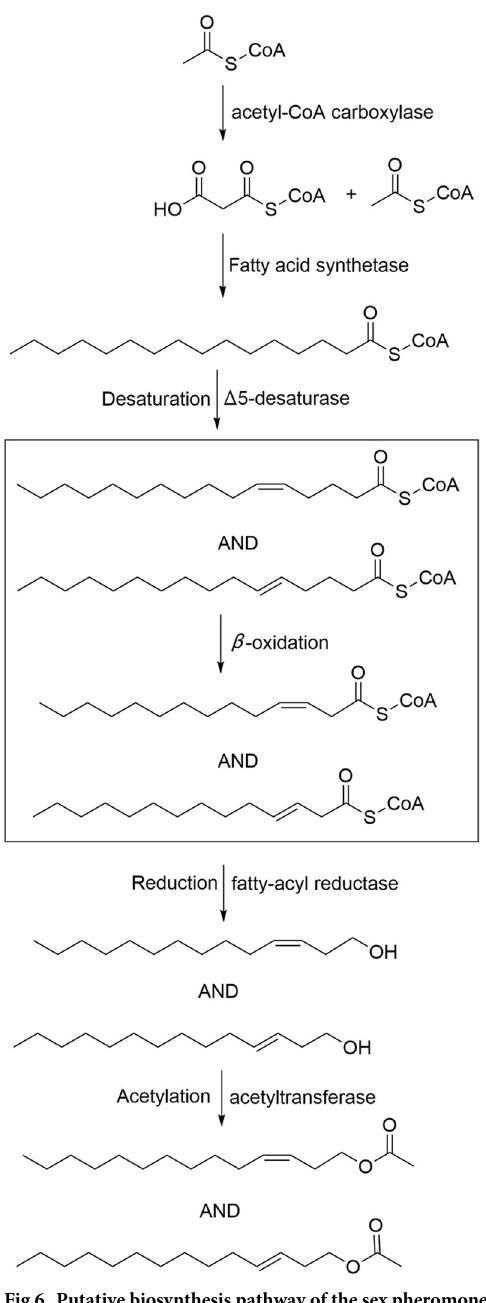
Fig 6. Putative biosynthesis pathway of the sex pheromone components Z3-14:OAc and E3-14:OAc in S . insularis . The saturated fatty acid precursor palmitic acid (16:0) is desaturated by Δ 5-desaturase to form the precursor Z/E5-16: acyl-CoA in the production of two major pheromone components (Z3-14:OAc and E3-14:OAc).